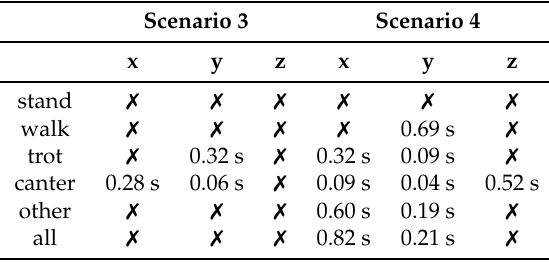
Table 9. Time (in seconds) a device has to harvest energy before one BLE packet of 10 bytes can be transmitted. An overview is given for different gaits and axis of the energy